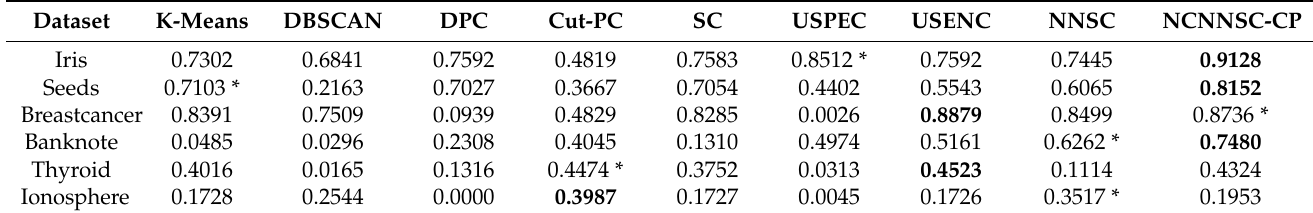
Table 4. The ARI of the nine algorithms on six UCI datasets.